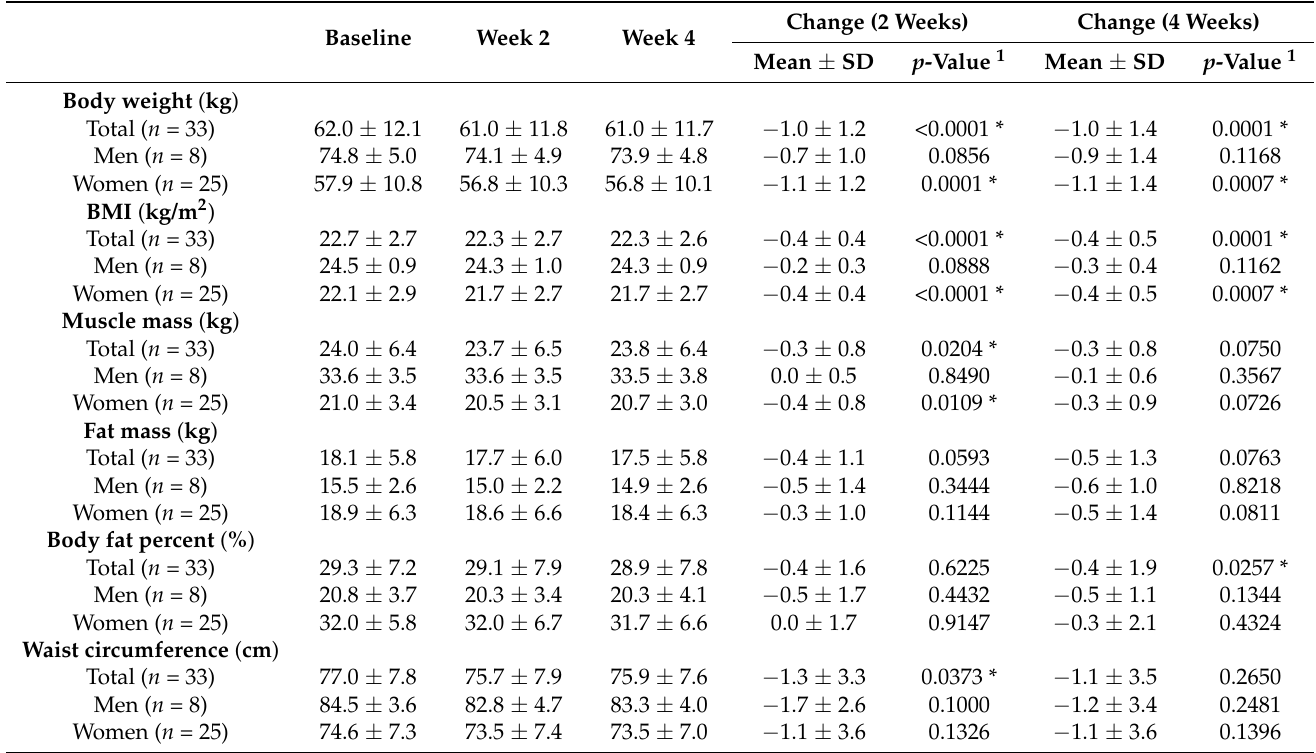
Table 2. Changes of body composition measures after 4 weeks of time-restricted